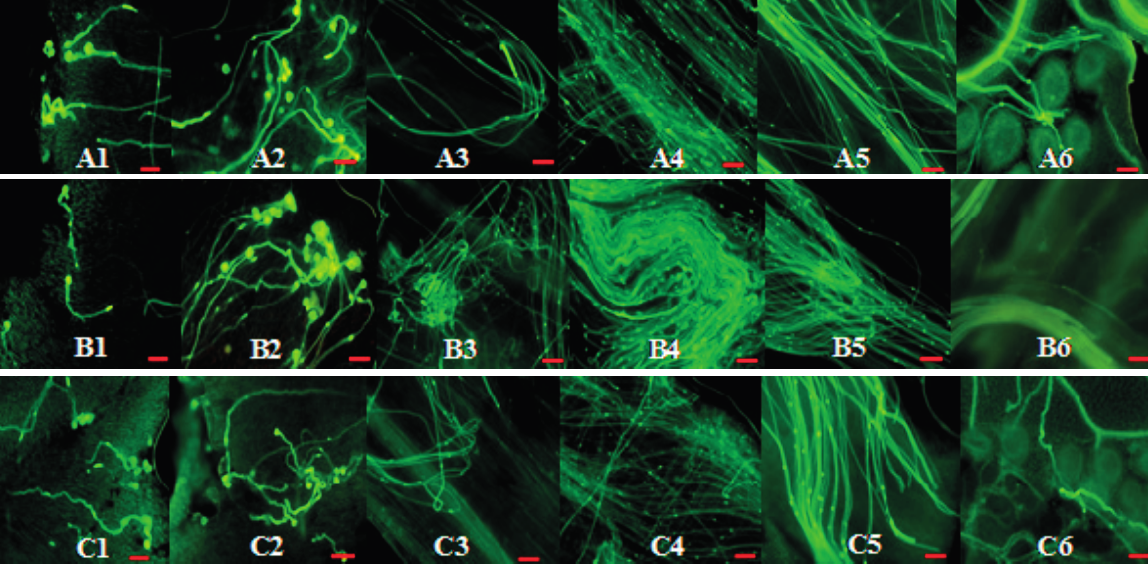
Figure 4. Pollination and fertilization of CrWSKP1 transgenic tobacco at different stages